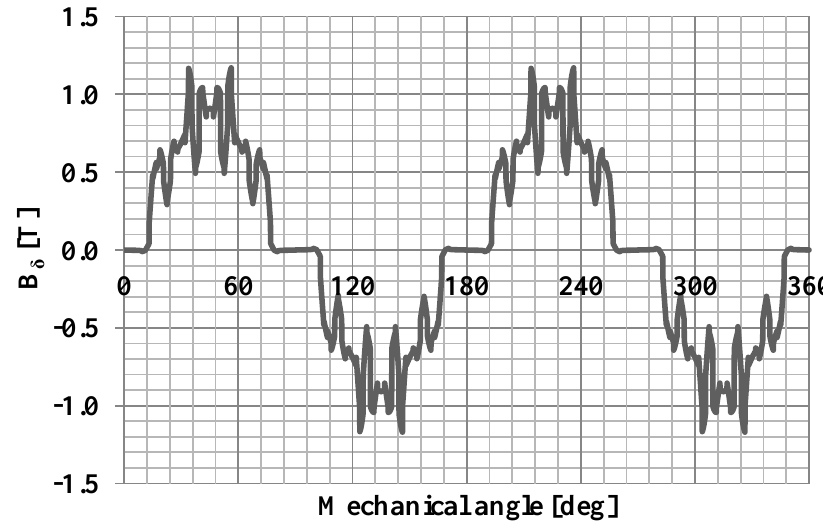
Figure 11. Distribution of flux density in air gap of motor.